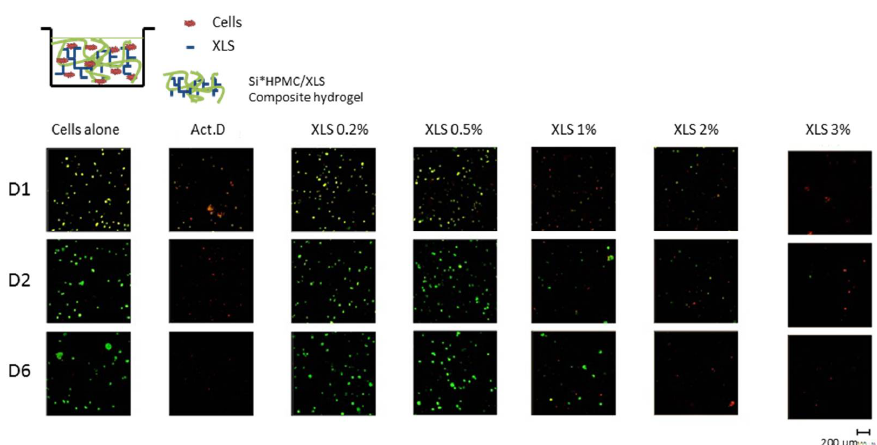
Figure 8. Three-dimensional (3D) viability of SW1353 cultured into Si-HPMC hydrogel containing increasing concentrations of XLS using the protocol B. SW1353 viability was evaluated in 3D after molding Si-HPMC hydrogels containing increasing concentrations of XLS (0–3%) and mixed with 1 × 10 6 SW1353 at day 1, 2, and 6 by Live/Dead Cell Viability assay. Living cells were stained by Calcein AM in green and dead cells were stained in red by ethidium homodimer-1. Negative control was obtained by adding actinomycin D (Act.D; 5 μg/mL) in the culture medium. The pictures are representatives of all the 3D images of all the conditions, times, and levels of the hydrogels. Scale bar: 200 μm.